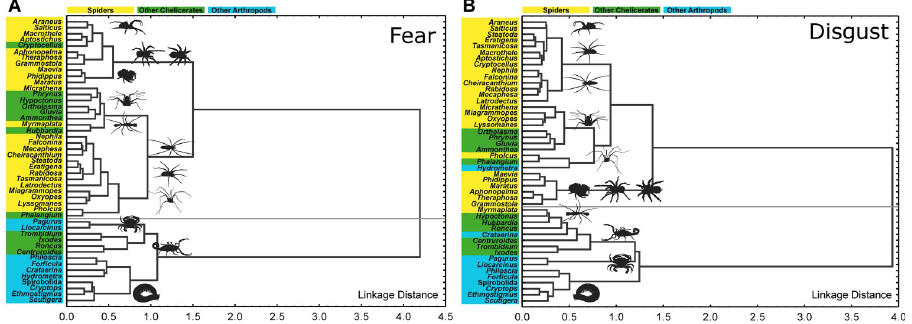
Fig 3. Cluster trees based on fear (A) and disgust (B) scores. In both cases, spiders and spider-like chelicerates form a clearly separate cluster from the rest of the stimuli, i.e., myriapods, crustaceans, insects, and the rest of chelicerates (including the scorpion and tick). Spider cluster further splits into three subclusters: robust hairy spiders, spider-like chelicerates, and gracile